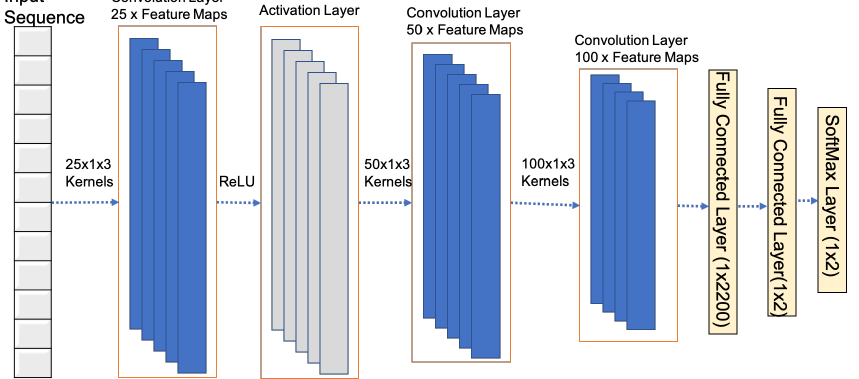
Figure 2. Structure for the proposed baseline 1D-CNN